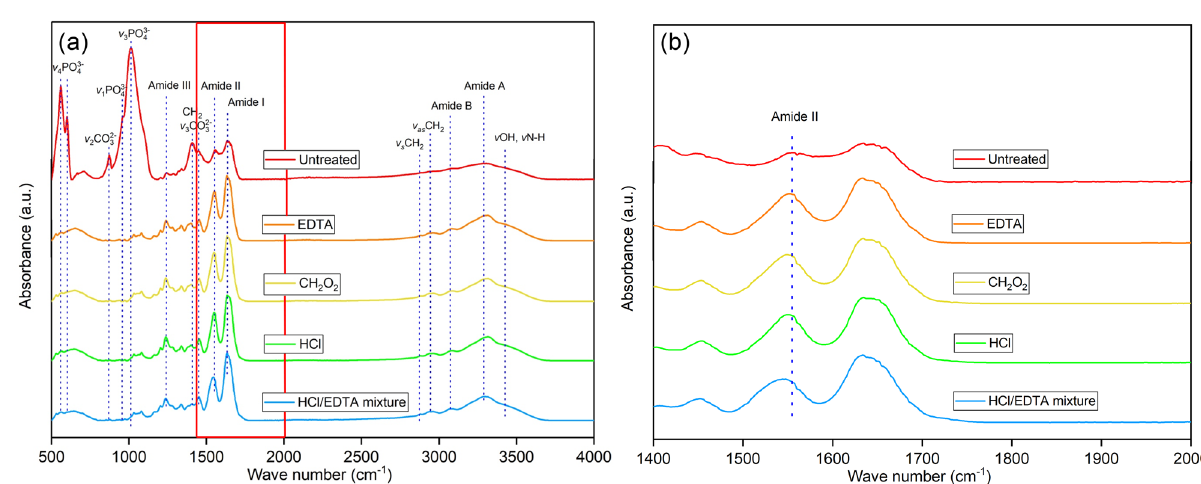
Figure 3. (a) Fourier-transform infrared spectra for untreated bone and for ethylene-diamine tetraacetic acid (EDTA), formic acid (CH 2 O 2 ), hydrochloric acid (HCl), and the HCl/EDTA mixture treated bone. (b) Magnified spectra from the boxed region in (a) showing the shift in the amide II